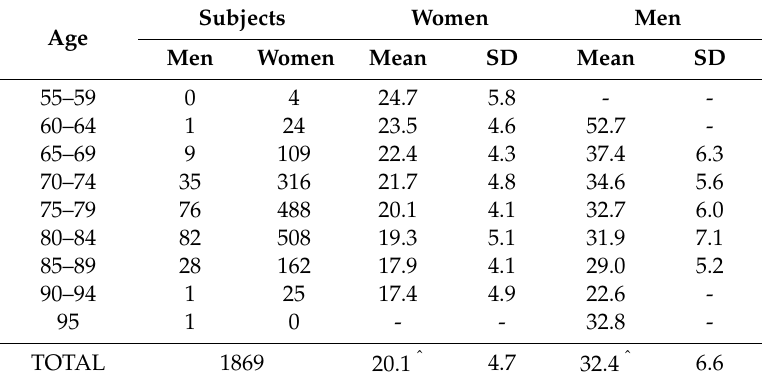
Table 1. Results by age groups and gender for handgrip strength (kg) ( n = 1869) *.